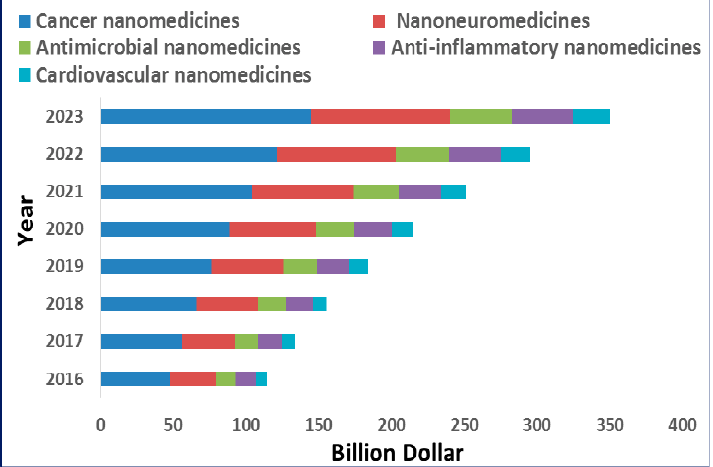
Figure 6. Illustration depicts worldwide nanomedicine market revenue in terms of different therapeutics areas (source; based on market data forecast and Infoholics Report December